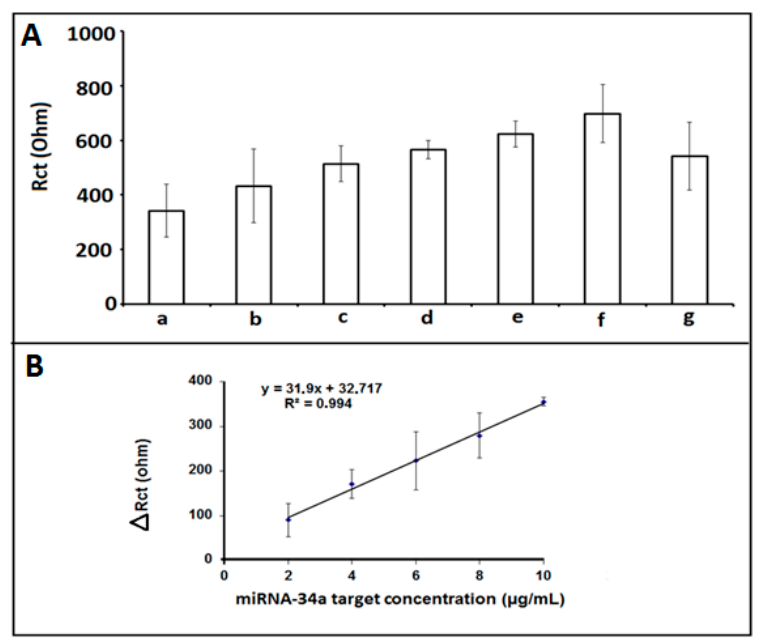
Figure 5. ( A ) Histograms representing the R ct values obtained by ( a ) 1 µg/mL miRNA-34a DNA probe, after hybridization between 1 µg/mL miRNA-34a DNA probe and different miRNA-34a RNA target concentrations ( b ) 2 µg/mL, ( c ) 4 µg/mL, ( d ) 6 µg/mL, ( e ) 8 µg/mL, ( f ) 10 µg/mL ( g ) 12 µg/mL. ( B ) The calibration graph obtained from R ct values measured in the presence of different concentration of miRNA-34a target, ranging 2–10 µg/mL.